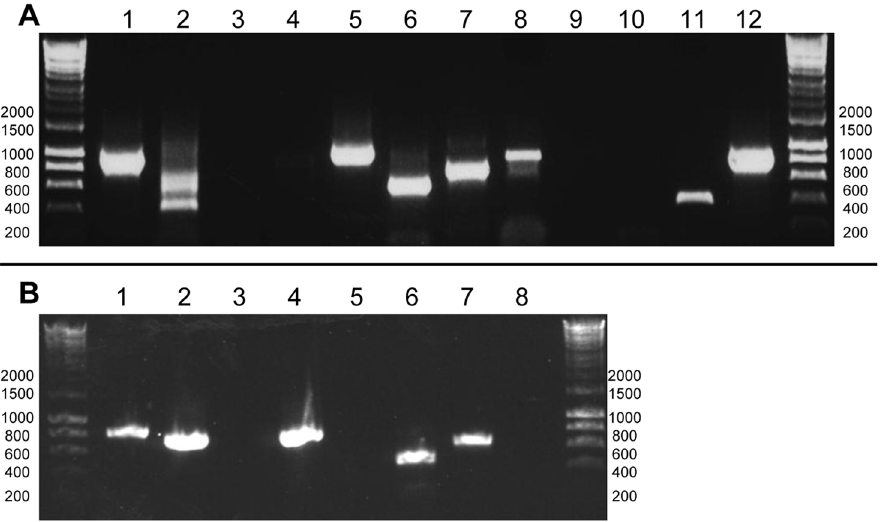
Figure 1. Determining the poly(U) state of representative chloroplast genes from C.velia and V.brassicaformis . Hyperladder I (Bioline) was used as a size marker, with the positions of representative size bands given to the side of each gel photo. Panel A: RT-PCRs for Chromera velia (lanes 1–6) and Vitrella brassicaformis (lanes 7–12). Lanes 1–2, 7–8: Oligo-d(A) RT-PCRs for the photosynthesis genes psbA and atpB-2 ( C. velia)/atpB ( V. brassicaformis ); Lanes 3–4, 9–10: oligo-d(A) RT-PCRs for the non-photosynthesis genes rps11 and rrs ; Lanes 5–6, 11–12: RT-PCRs using an internal, gene-specific cDNA primer for rps11 and rrs for both species. The multiple bands observed for C. velia atpB-2 (lane 2) correspond to different atpB(2) transcripts containing alternative poly(U) sites. Panel B control RT-PCRs. Lanes 1–2: oligo-d(A) and internal gene-specific RT-PCRs for Amphidinium carterae p s bA ; lanes 3–4: oligo-d(A) and internal gene-specific RT-PCRs for Phaeodactylum tricornutum psbA ; Lanes 5–6: oligo-d(A) and internal gene- specific RT-PCRs for C. velia Hsp90 ; lanes 7–8: PCR positive (DNA template) and negative controls (no template) for C. velia psbA